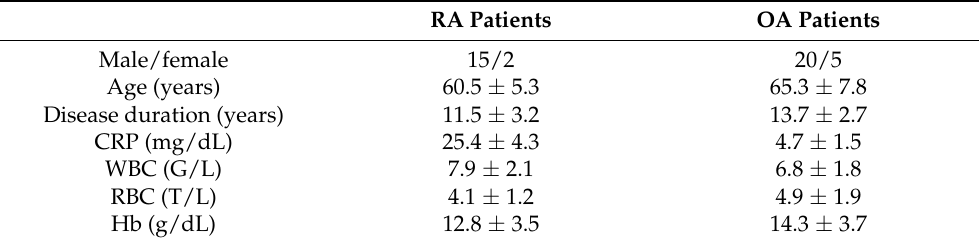
Table 1. Clinical characteristics of